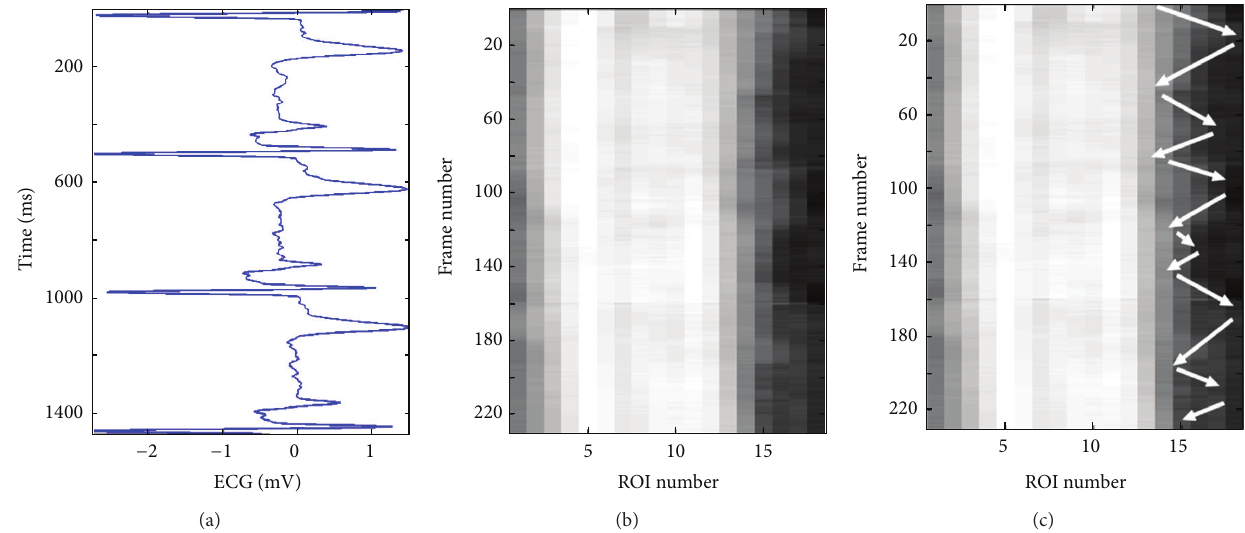
Figure 13: Spatiotemporal wave representation for the elderly case E1 in Figure 12. The ECG signal is shown to the left (a) and the spatiotemporal 2D map is shown to the right (b). The longitudinal motion, across neighboring ROIs, is marked by white arrows on the spatiotemporal 2D map